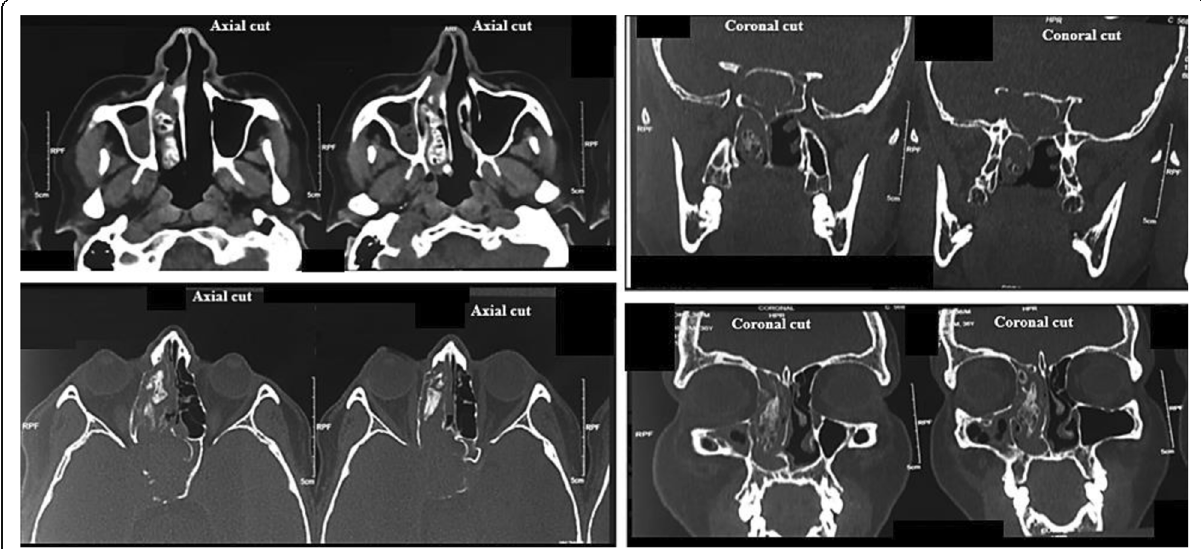
Fig. 1 CT scan of PNS showing chronic sinonasal polyposis pattern of inflammatory process with secondary fungal